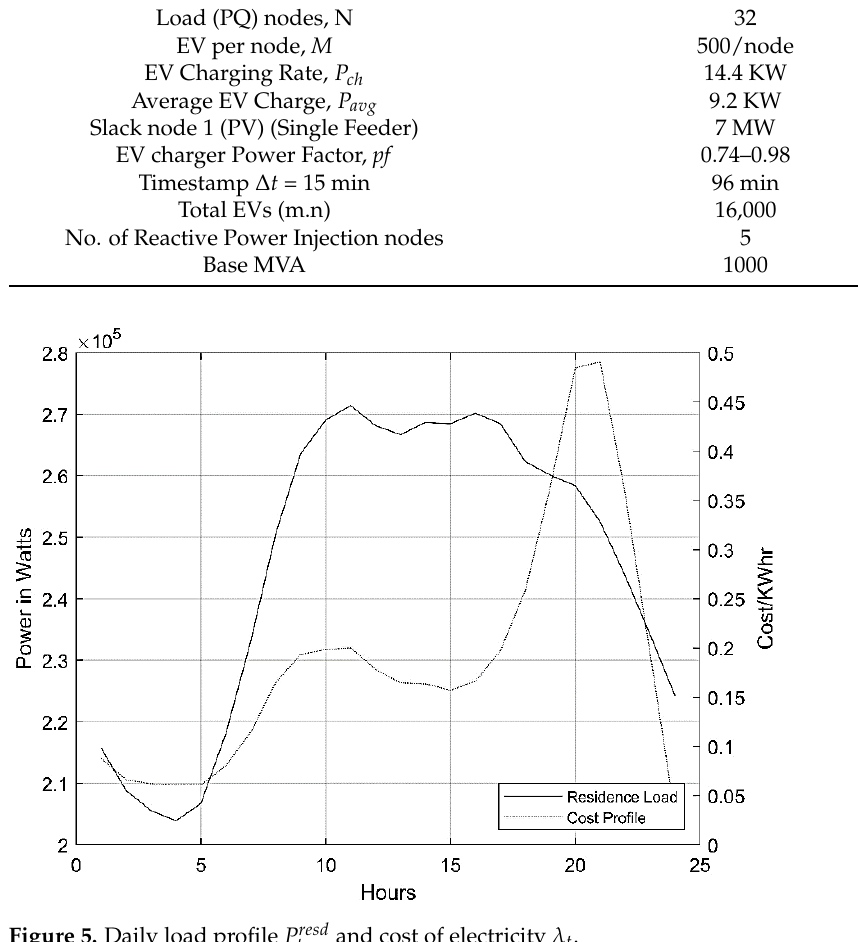
Figure 5. Daily load profile 𝑃 𝑡 𝑟𝑒𝑠𝑑 and cost of electricity 𝜆 𝑡 .